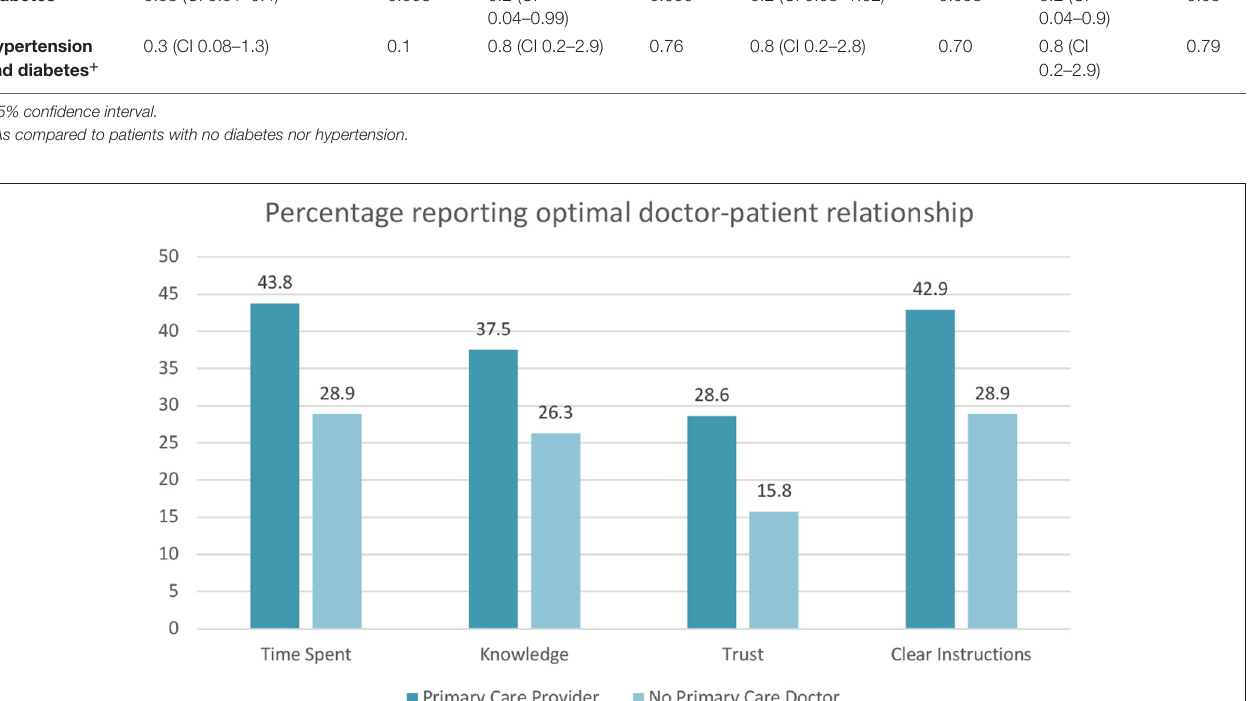
p value Odd ratio —Trust * p value Odds Knowledge of patient medical history *